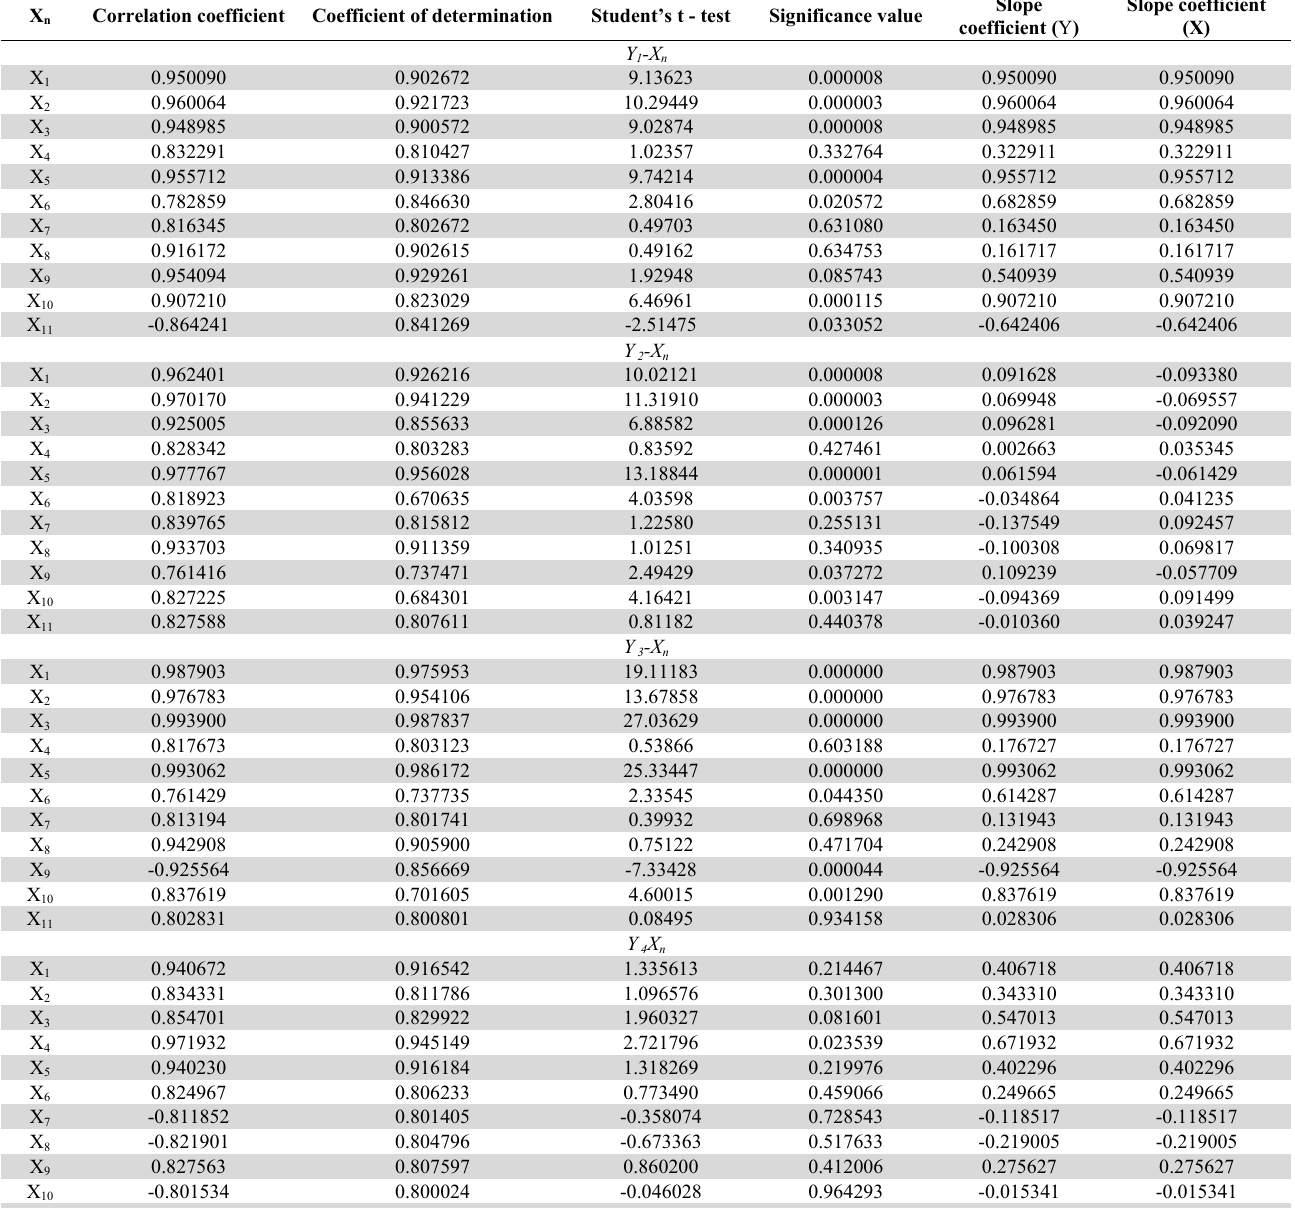
Analysis of factors’ impact on the volumes of sold food